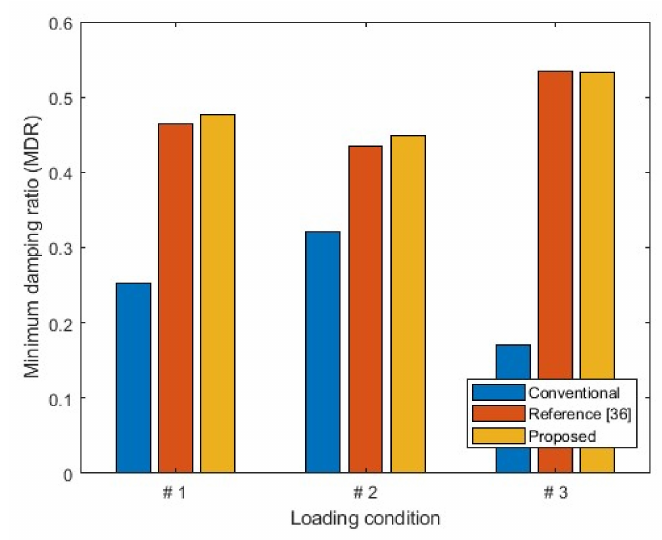
Figure 12. MDR comparison for three selected operating situations (first network).